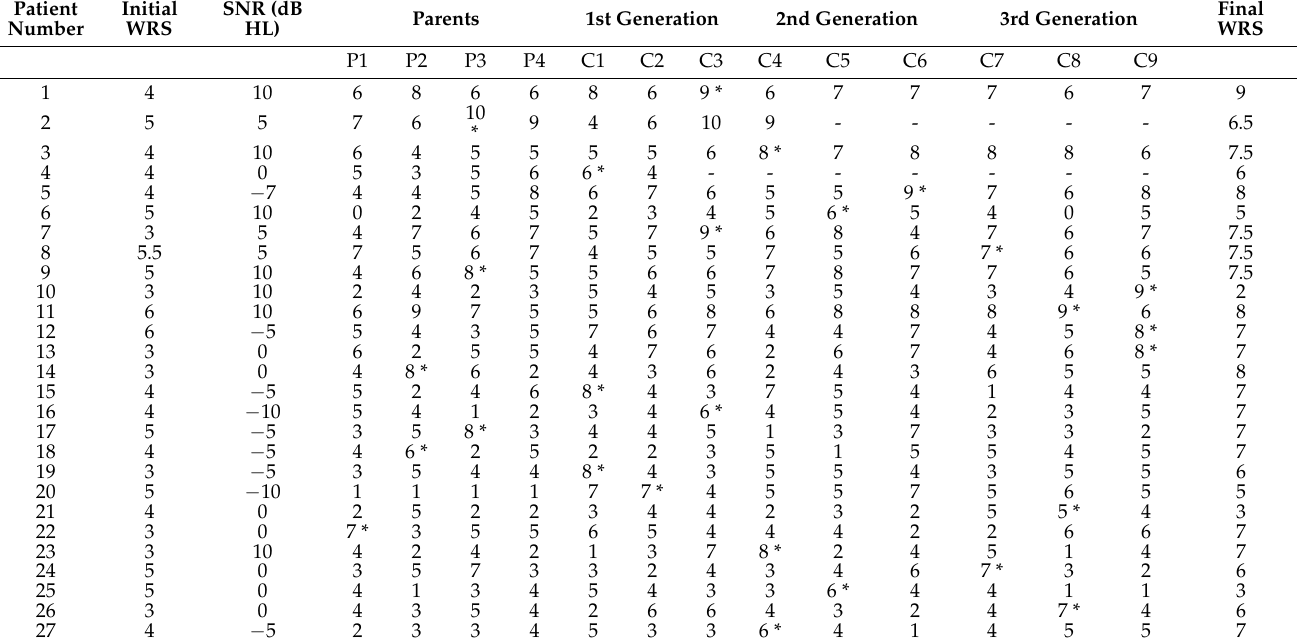
Table 2. WRS for each fMAP generated by the evolutionary algorithm (P1–4 and C1–C9). Asterisk indicates the selected final fMAP. Initial and final WRS (45–60 days after fitting) were tested by 20 words and intermediate WRS by 10 words. All were expressed as a score out of ten. All tests were conducted at the same signal/noise ratio (SNR). Minus sign (-): the patient was not willing to test the fMAPs and abandoned the